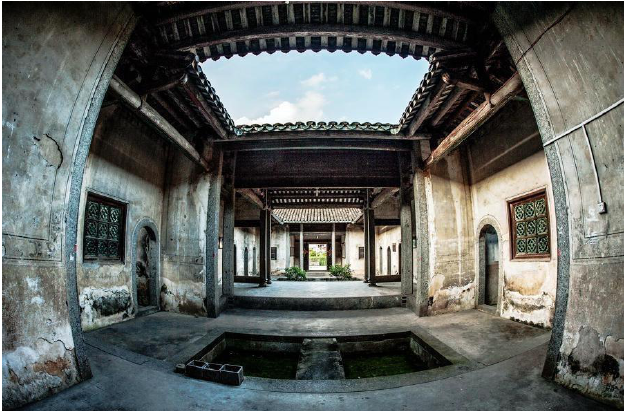
Figure 13. The interior of the Dragon House.